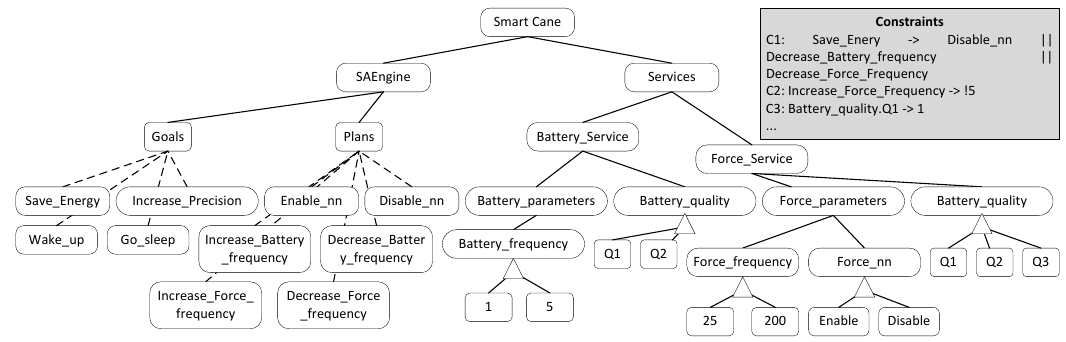
Figure 4. Feature model of the DSPL of the Smart Cane